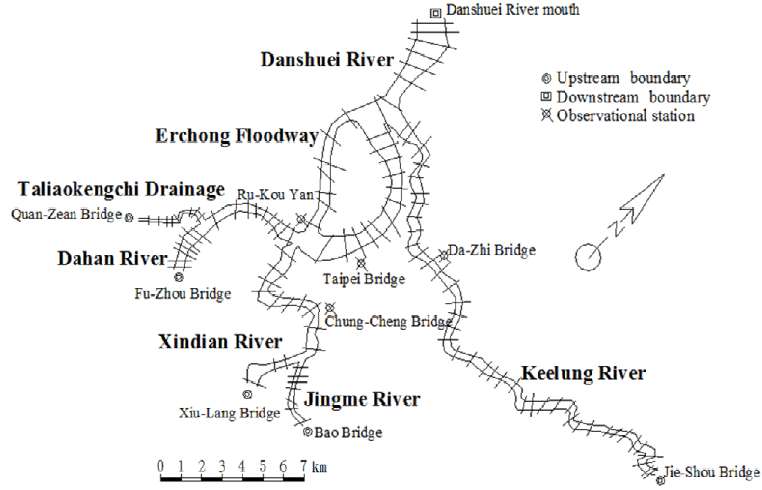
Figure 1. Layout of the Danshuei River system in northern Taiwan. The transect line represents the